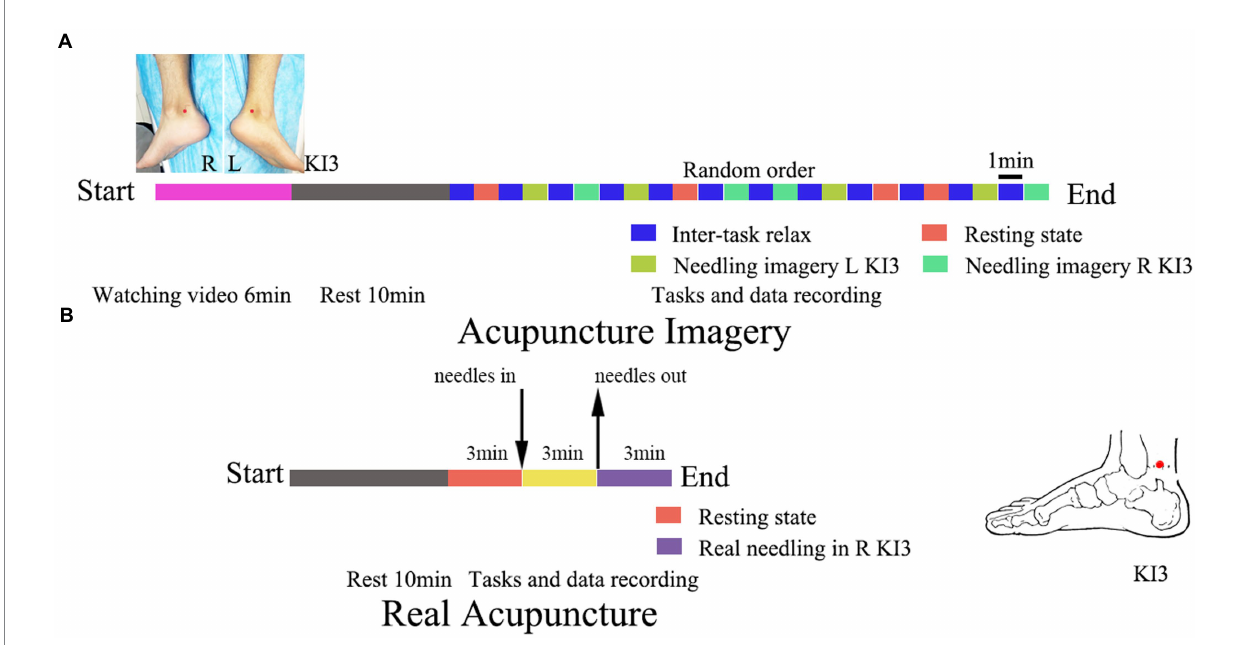
FIGURE 1 Trial flowchart of acupuncture imagery (A) and real acupuncture (B) . The location of acupoint KI3 has been marked with red dot. L, left; R,